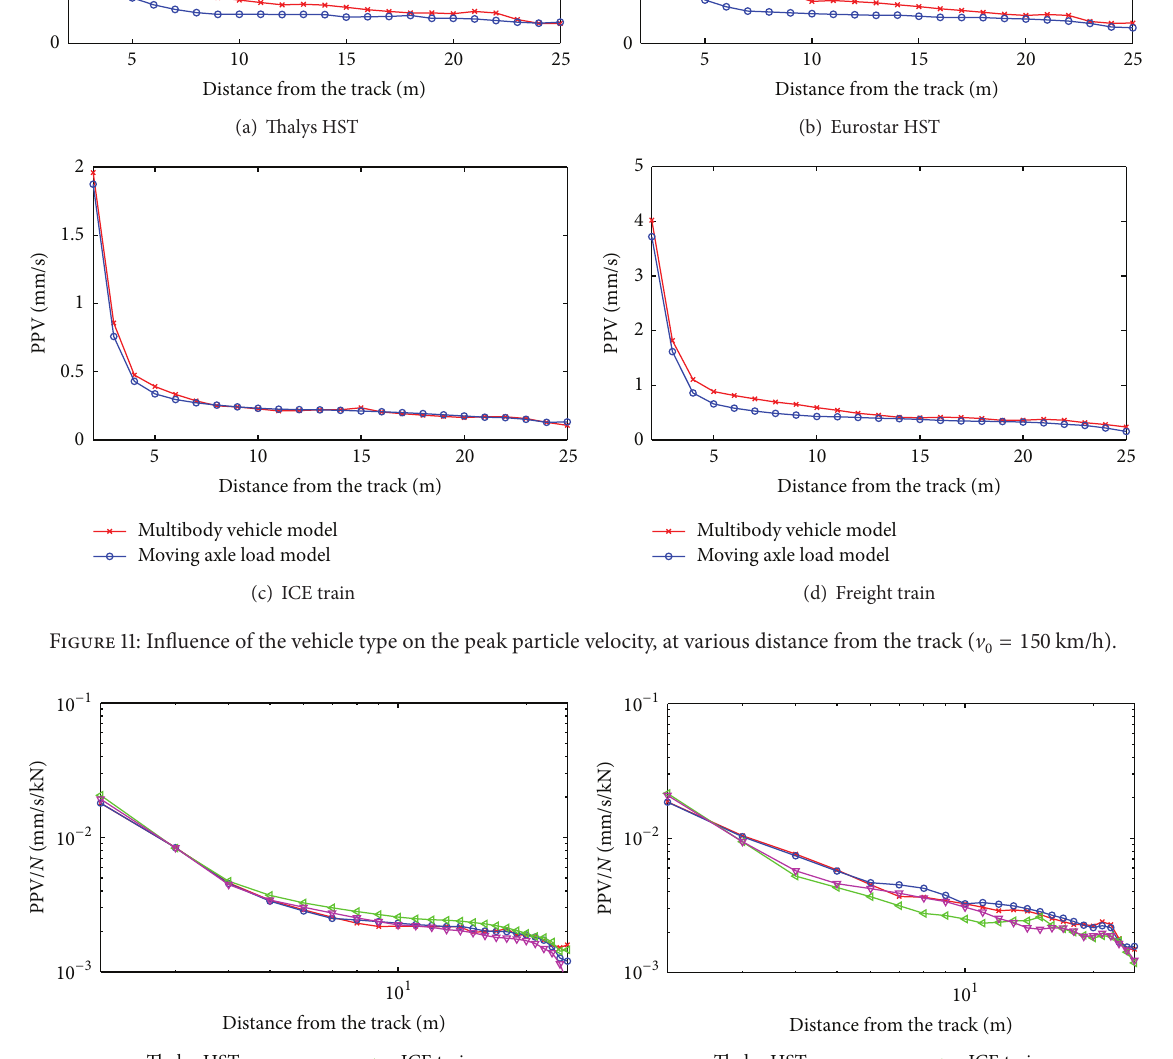
Distance from the track (m)